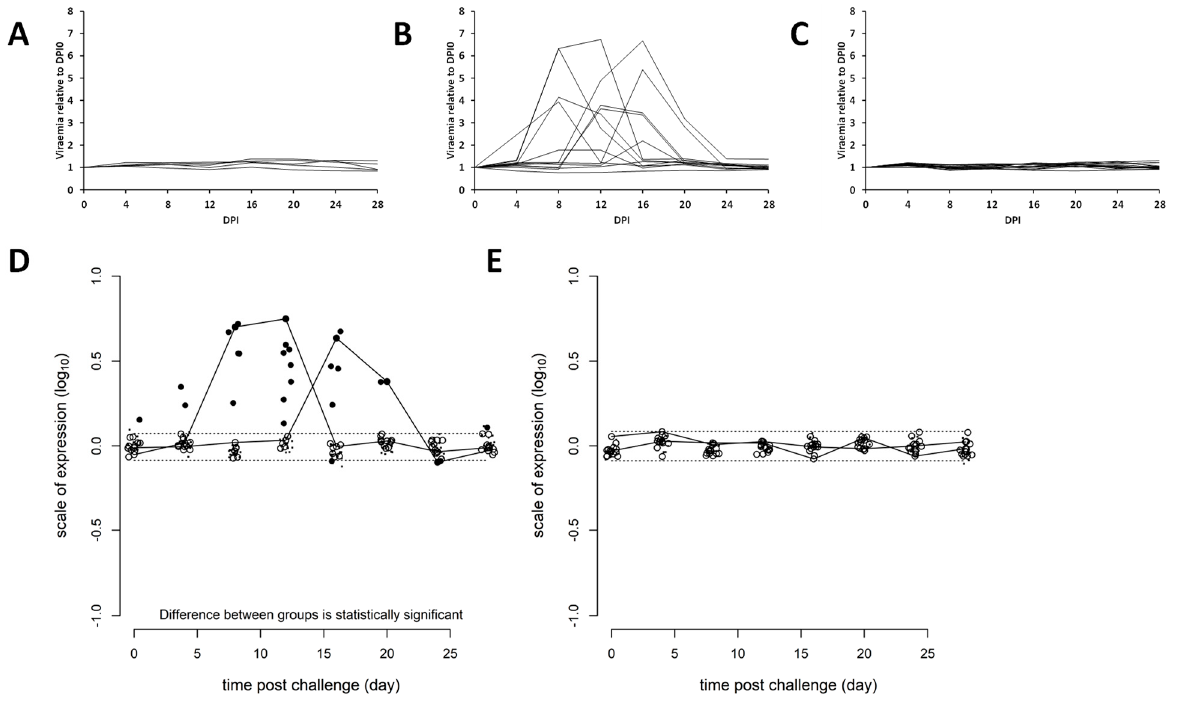
Figure 4. Individual kinetics of viremia in PBS-injected-uninfected ( A ), 3.1H-injected-infected ( B ), and ppG-injected-in- fected fish ( C ). Statistical analysis using an R-script designed for analysis of individual kinetics (Collet al., 2015) comparing viremia in ppG-injected-infected fish (open circles) and 3.1H-injected-infected groups (close circles) ( D ) and between ppG- injected-infected fish (open circle) and PBS-injected-uninfected groups (close circle) ( E ). The discontinued lines represent the 95% confidence intervals and values outwith these are statistically significant. Two representative individual viremia kinetics are shown in ( D ).3.3. Viremia Kinetics: Individual Non-Lethal Fish Sampling Versus Simulated Lethal